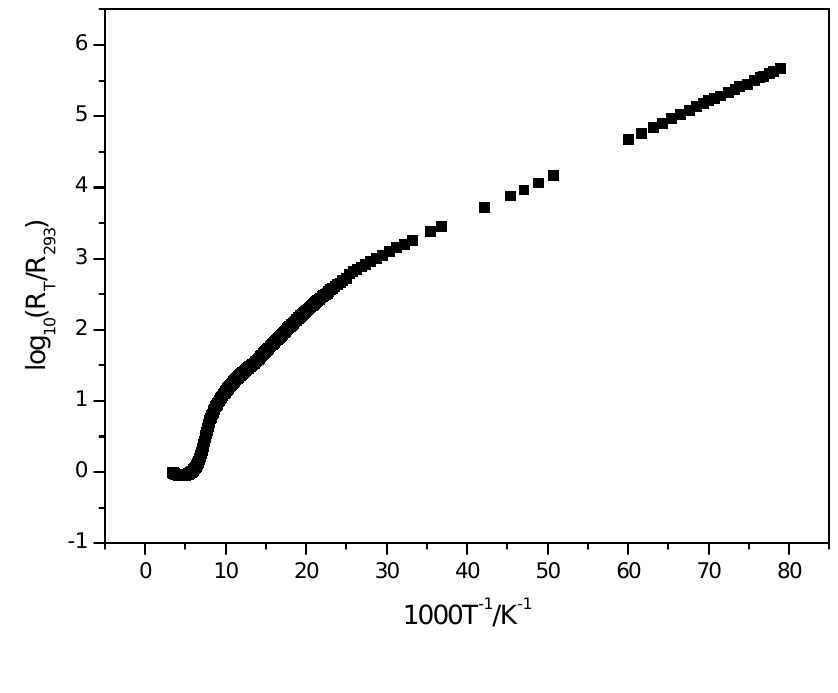
Figure 4. Temperature dependence of resistance for a single crystal of